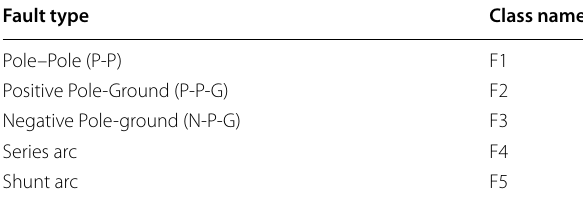
Table 2 Type of Faults and classes